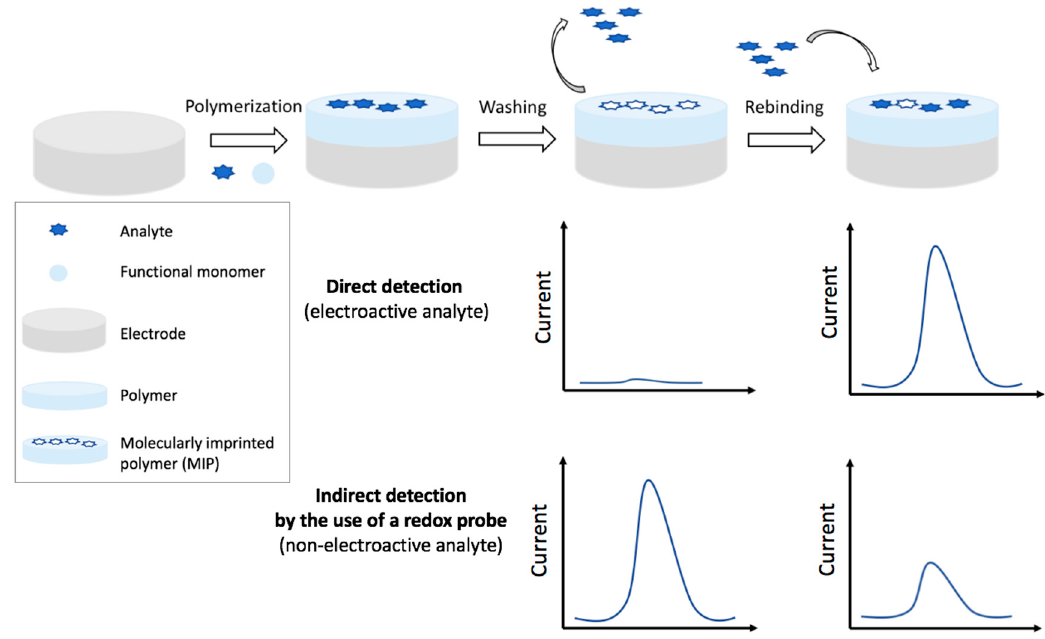
Figure 6. Schematic representation of an electrochemical molecular imprinted polymers (MIP) sensor production and detection of the analyte: direct detection and indirect detection by the use of a redox probe.